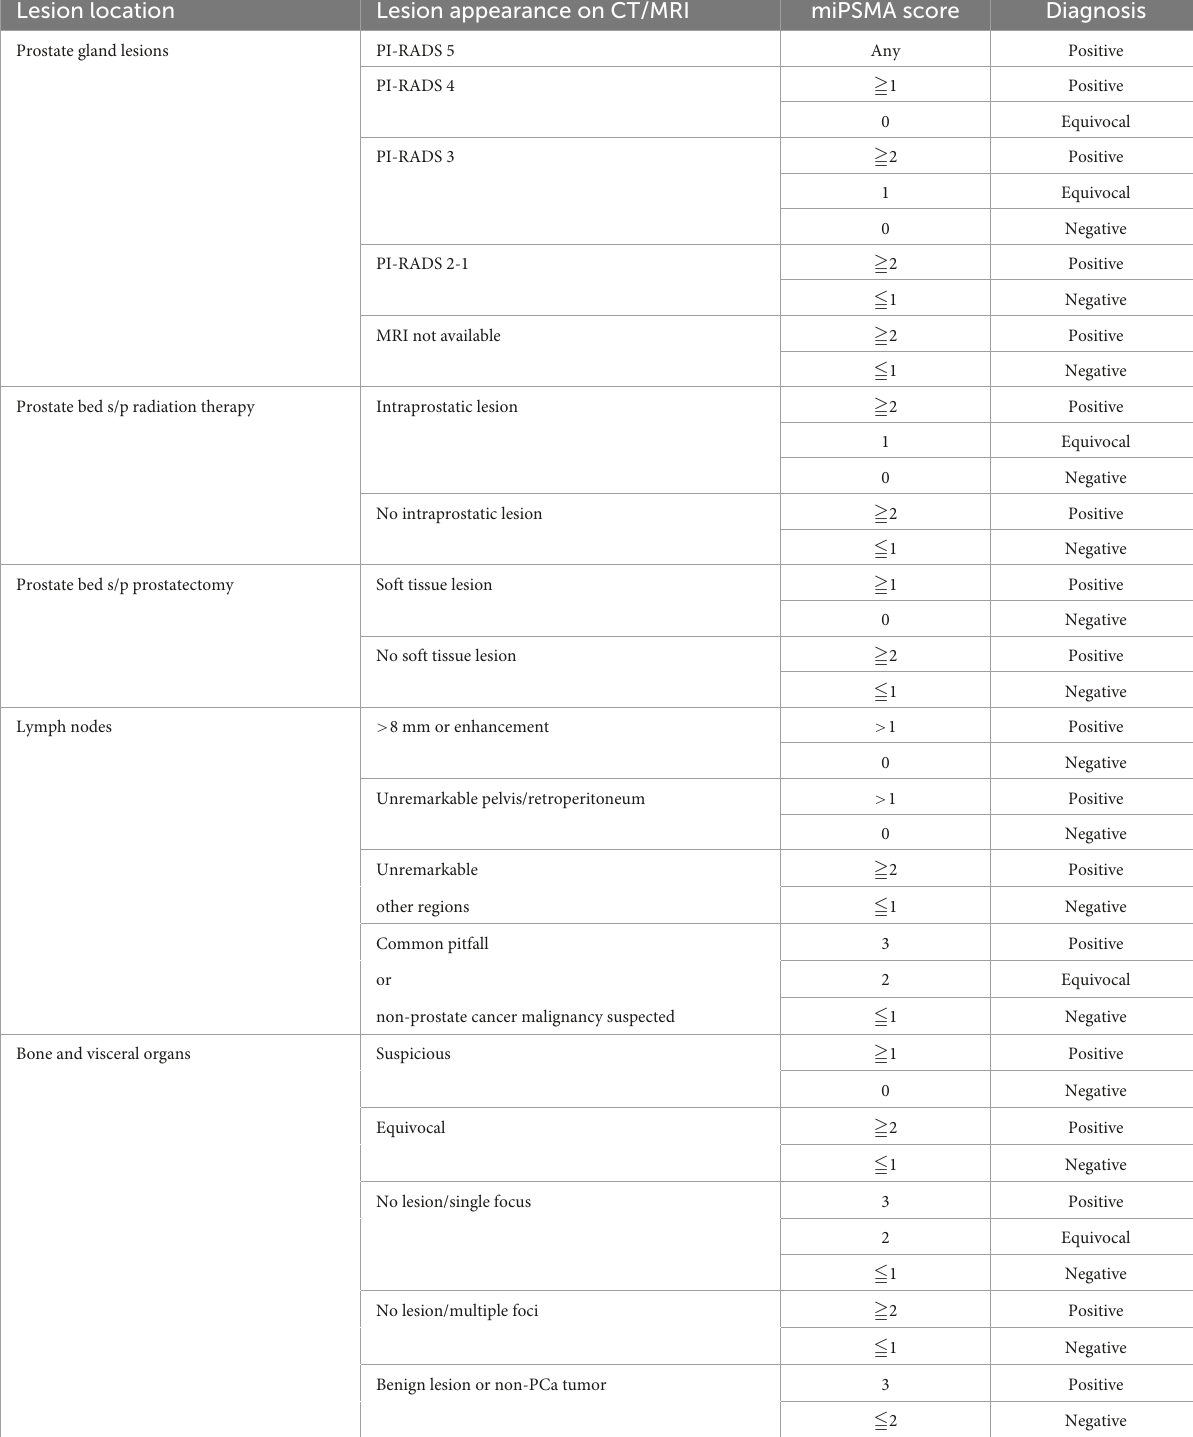
TABLE 4 Guide for interpretation of PSMA-avid lesions according to location and morphology. Lesion location